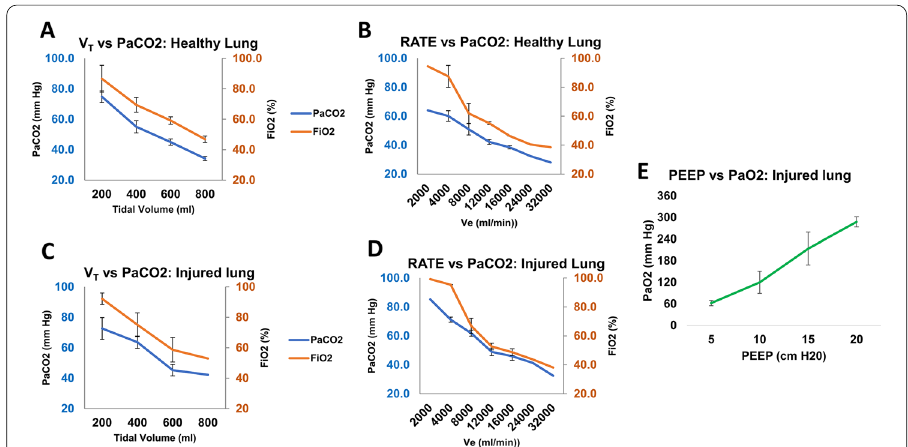
Fig. 3 Porcine study results ( n 6). A , B Variation of PaCO 2 and PaO 2 by adjusting Tidal volume, Respiratory = Rate or PEEP in normal or C – E injured lung porcine model. T I (1 s) and oxygen flow rate (5 L/min) were